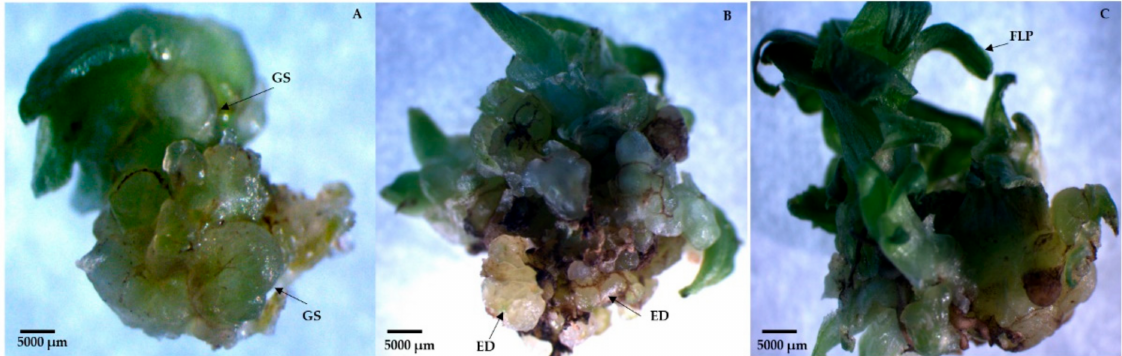
Figure 2. Somatic embryos formed directly from ‘MD2’ hybrid pineapple explants in M3 treatment. ( A , B ) Direct formation of globular structures (GS) from leaf explants, (ED) advance stage of embryo development. ( C ) Asynchronous development of formed embryos; FLP: foliar leaf